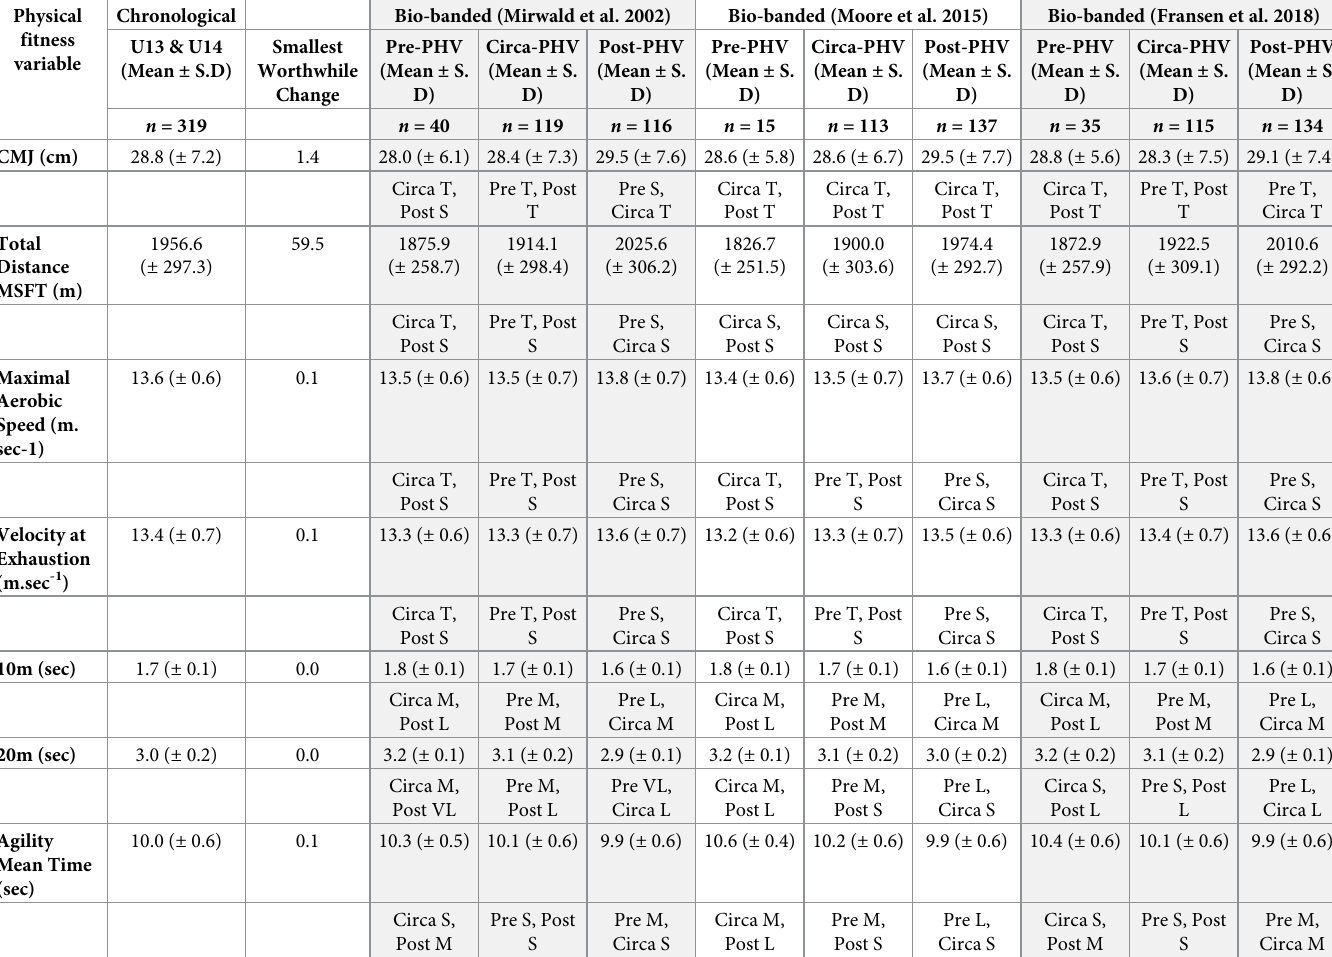
Table 2. Summary table of the mean values and between maturity grouping effect sizes for U13 and U14 academy soccer players physical fitness characteristics when categorised using an aggregated chronological age group or three different Mirwald, Baxter-Jones [23], Fransen, Bush [24] and Moore, McKay [29] bio-band- ing (pre-PHV, circa-PHV and post-PHV)